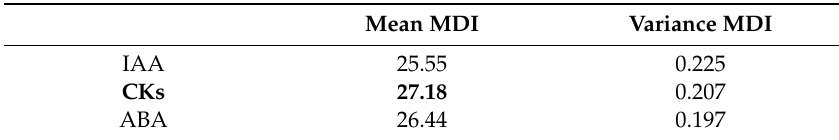
Table A2. Random forest classification for shoot data. Mean decrease in impurity as a measure of significance for